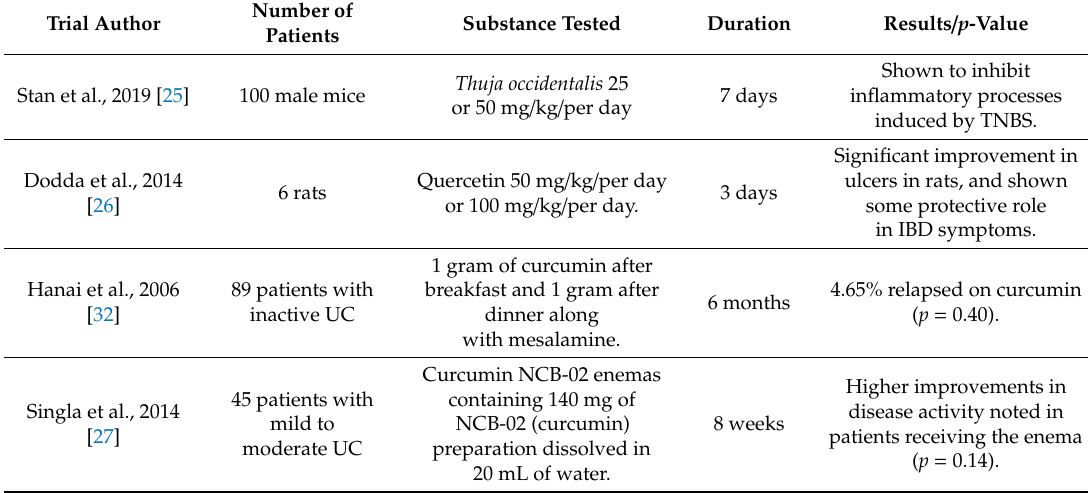
Table 2. Summary of trials examined for e ff ectiveness of Polyphenols on